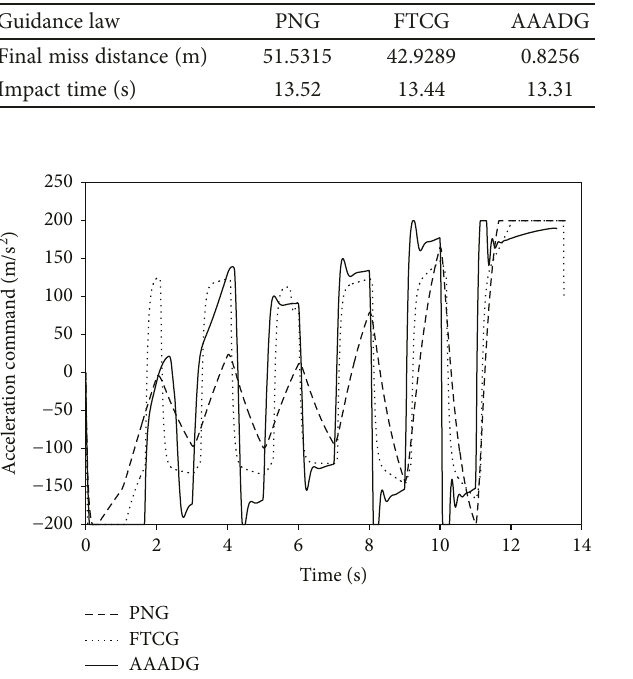
Figure 7: Accelerations under three guidance laws.